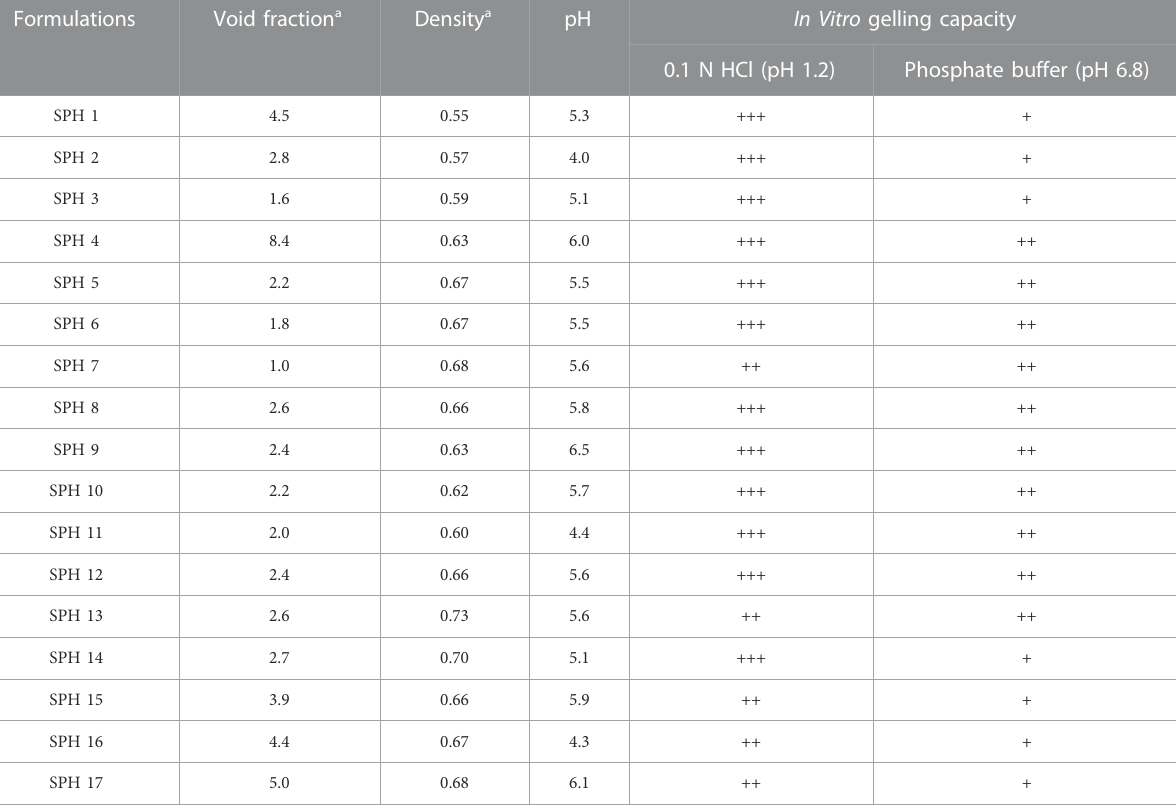
TABLE 5 Results of density, pH, Void fraction and in vitro gelling capacity of superporous hydrogel formulations in 0.1 NHCL (pH 1.2) and phosphate buffer (pH 6.8).